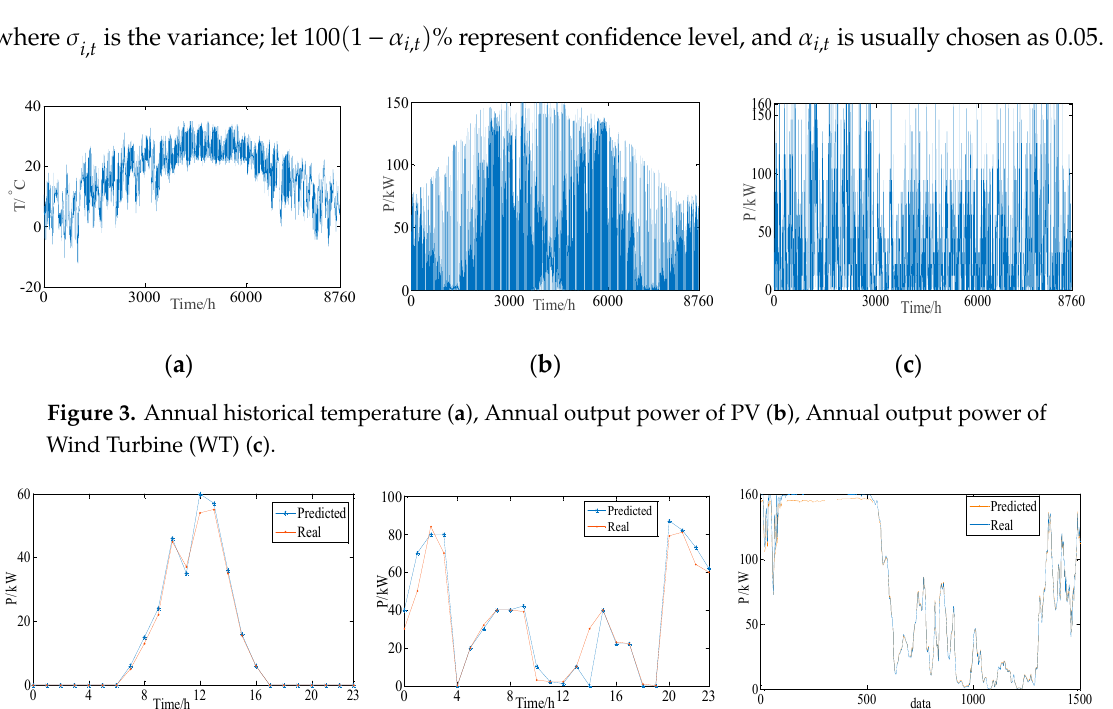
Figure 2. Neural network model for Photovoltaic (PV) power generation prediction. where represent the prediction output value. The input of model from P 1 to P 6 are historical power, light intensity, temperature, humidity and the temperature, humidity of the predicted day, respectively.